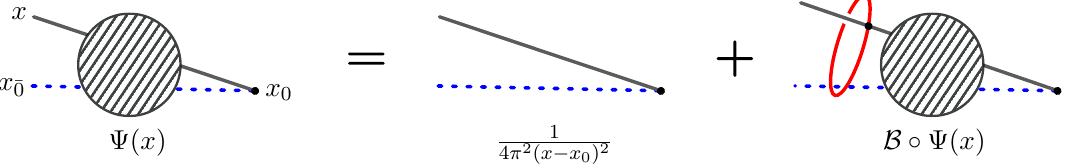
Figure 9 . The correlator (4.2) satis(cid:12)es a Dyson-type evolution equation. On the right hand side we have the tree-level propagator ((cid:12)rst term) plus the correlator with one more wheel of the X -(cid:12)eld (in red). The addition of a wheel is implemented by the graph building operator B